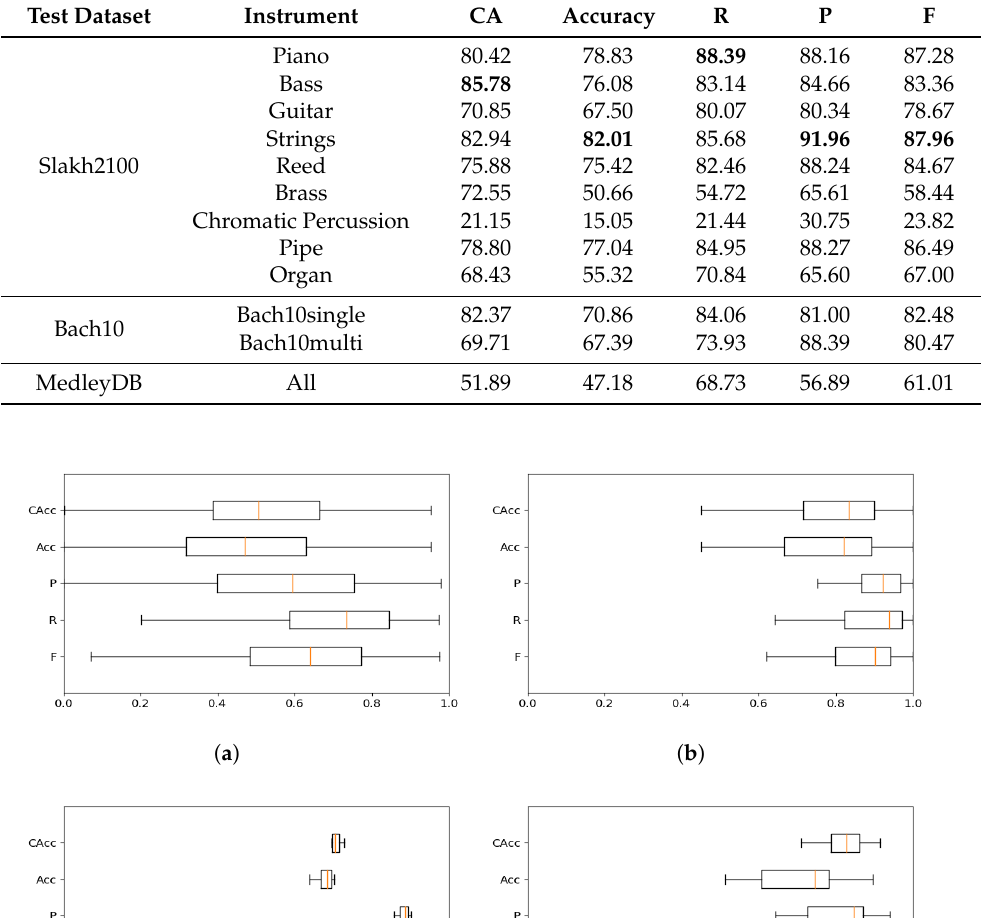
Table 2. Multi- f 0 metrics of our model for Slakh2100, Bach10 and MedleyDB datasets. Best result for every metric is highlighted in bold.